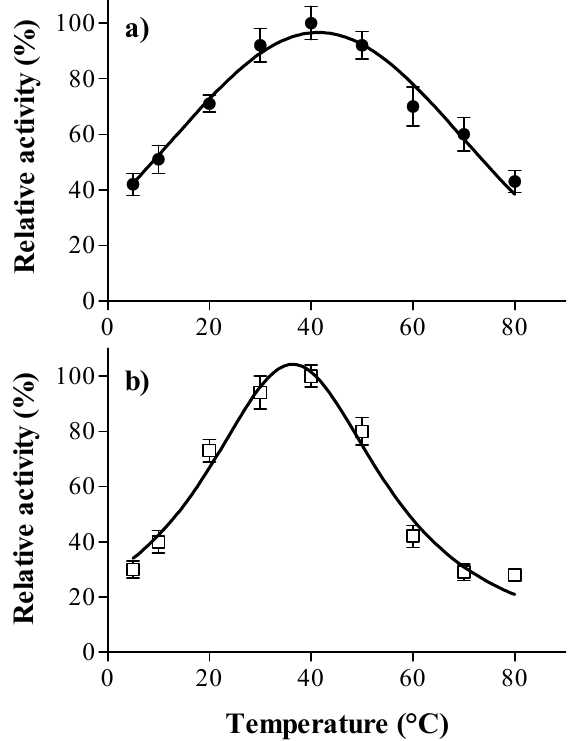
Figure 2. Effect of temperature on the activity of laccase ( ● , ( a )) and tannase ( □ , ( b )) from A. oryzae. Assays were performed in McIlvaine buffer using syringaldazine (1 mM) as a substrate for laccase and tannic acid (1 mM) as a substrate for tannase. The points represent the average values, and the error bars represent the standard deviation of the three replicates.